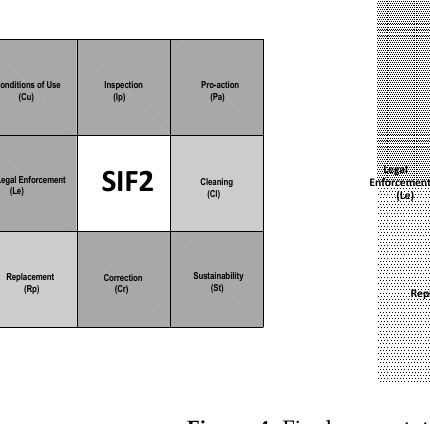
Figure 4. Final presentation of results.